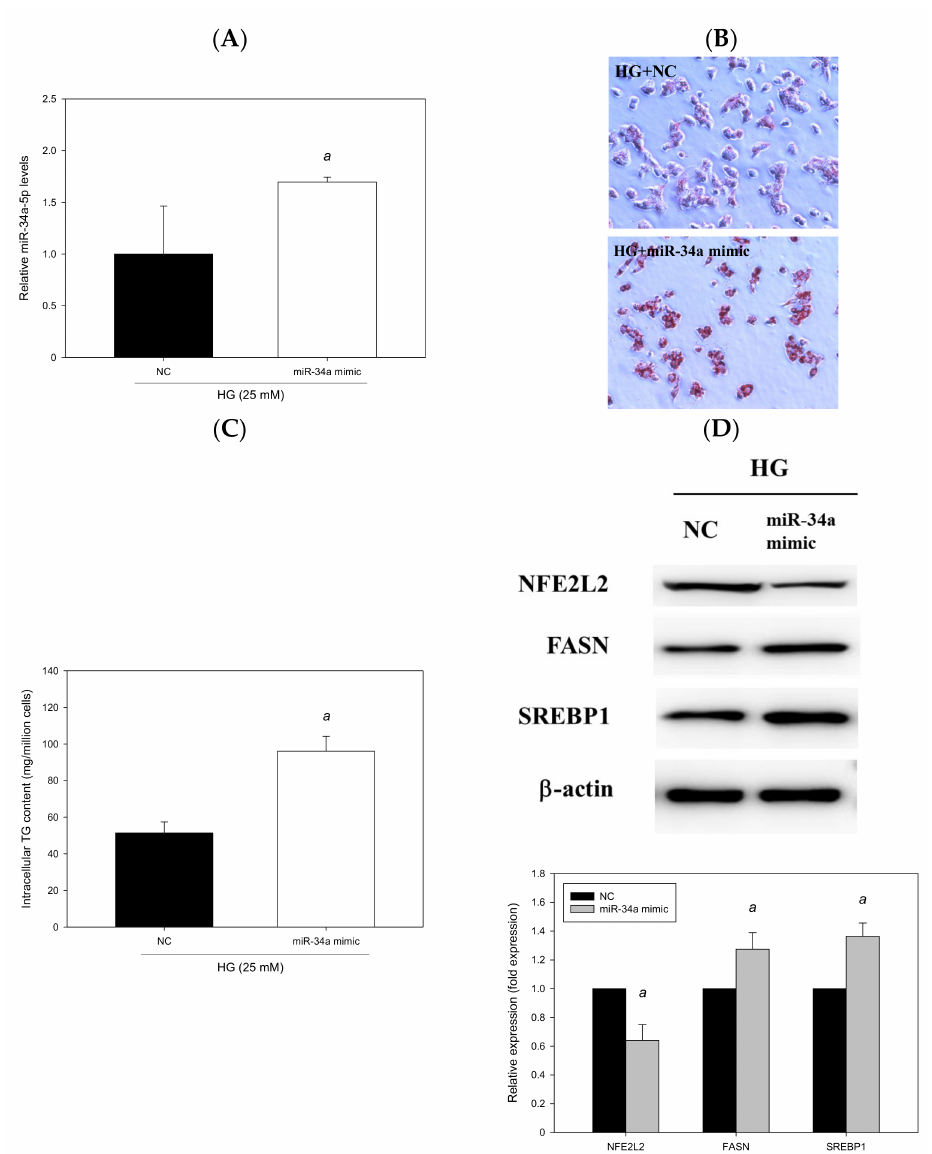
Figure 10. miR-34a-5p induced cellular lipid accumulation in HepG2 cells. HepG2 cells were transfected with an miR-34a-5p mimic or NC for 48 h. ( A ) Real-time PCR analysis of miR-34a-5p expression. ( B ) Oil Red O staining. ( C ) Intracellular triglyceride level. ( D ) Western blotting analysis of NFE2L2, FASN and SREBP1. a, p < 0.05 compared with the NC control